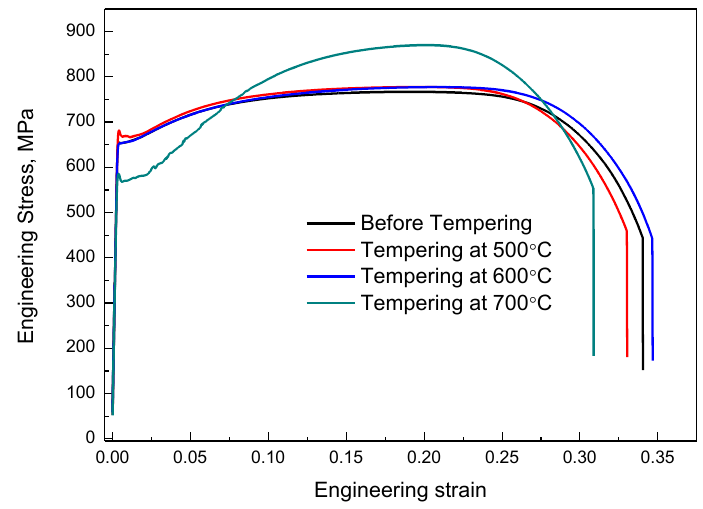
Figure 7. Engineering stress – strain curves for samples before and after tempering at 500 – 700 °C.